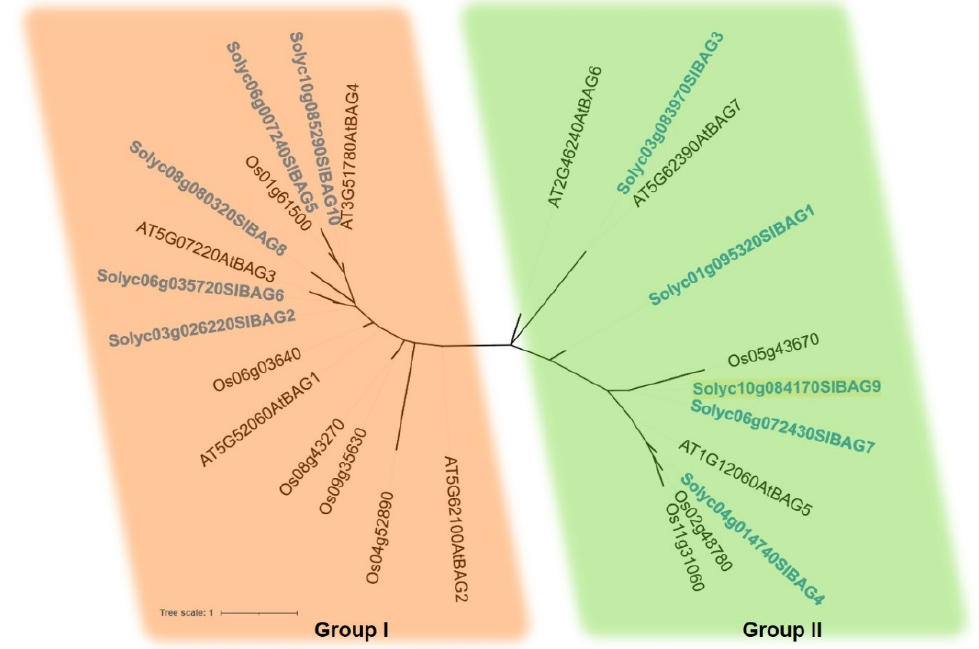
Figure 2. Phylogenetic tree of tomato SlBAG proteins. The 25 amino acid sequences of three plant species (Sl, Solanum lycopersicum ; Os, Oryza sativa ; At, Arabidopsis thaliana ) were generated using the PhyML in MEGA 7.0. Based on the phylogenetic data, these proteins are divided into two distinct sub-groups, which are distinguished with different colors.